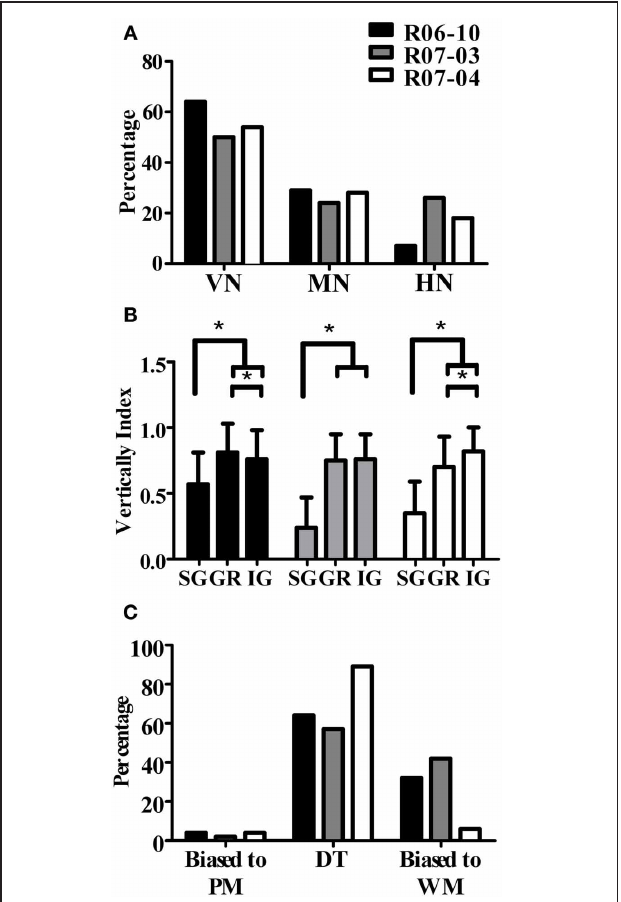
FIGURE 8 | Quantification of dendritic orientation. (A) Morphological types of S1 nitrergic neurons classified according to dendritic orientation. Half of these neurons display a vertically-oriented dendritic arbor (VN). The other half of the population is equally represented by multipolar (MN) and horizontally-oriented (HN) neurons. (B) Verticality index ( vi ) measured with wedge analysis of 3D-reconstructed S1 nitrergic neurons. Values obtained in supragranular layers (SG) are significantly lower than both granular (GR) and infragranular (IG) layers. This quantitative finding confirms the observation that vertically-oriented nitrergic neurons predominate in GR and IG, while in SG they tend to be horizontal or multipolar. Asterisk ( ∗ ) represents p < 0 . 01. (C) Most vertically-oriented neurons in S1 ( i.e ., presenting a verticality index equal or higher than 0.66) display their dendritic trees facing both the pia mater and the white matter, thus corresponding to double-tufted cells (DT). The second most common type of vertically-oriented neurons present a dendritic arbor facing the white matter only. PM: pia mater; WM: white